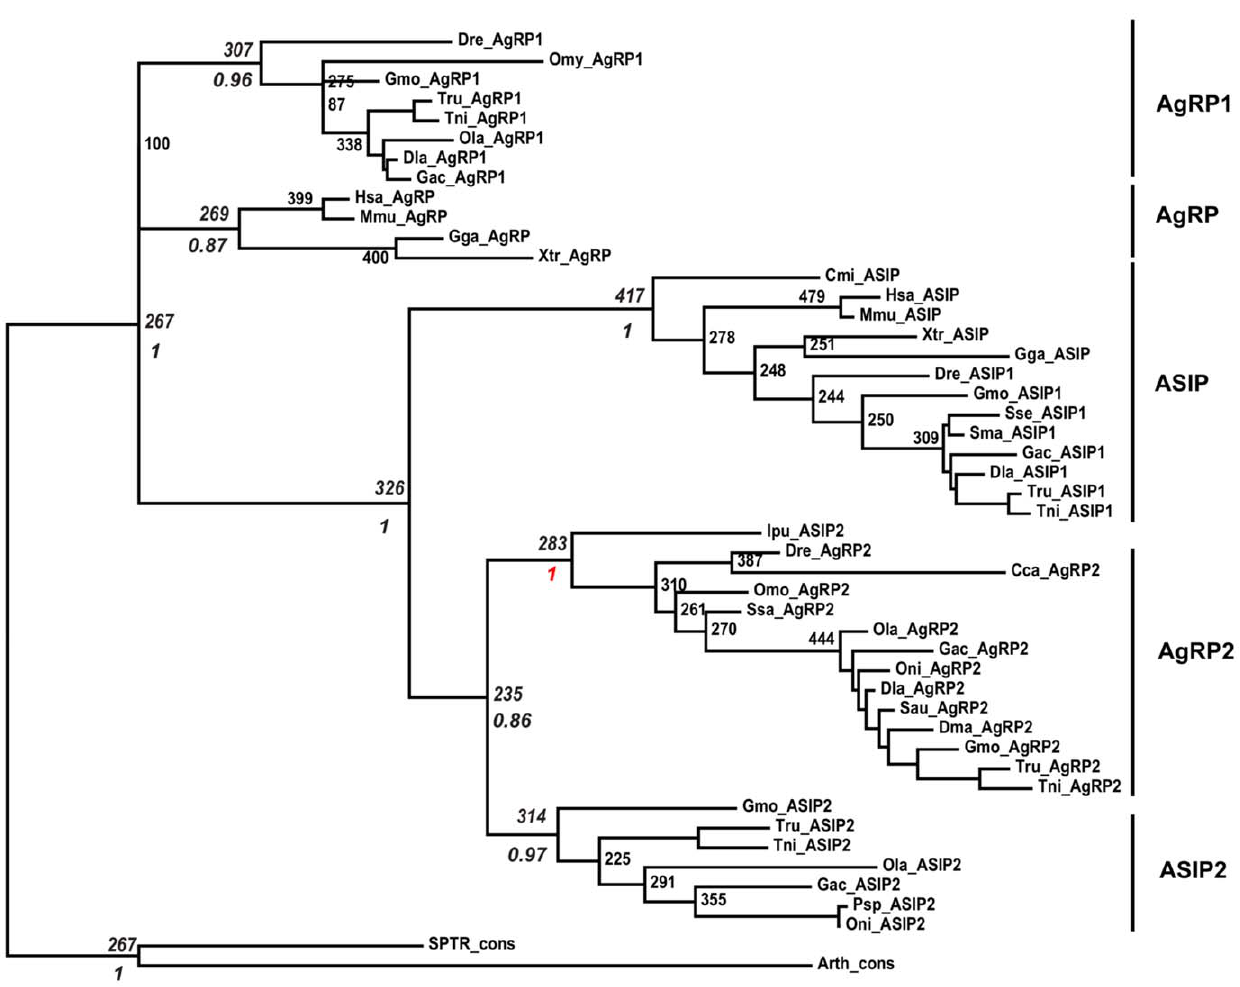
Figure 2. Phylogenetic analysis of Agouti-like sequences. The unrooted maximum likelihood phylogenetic tree of Agouti-like sequences. Robustness of the nodes is tested with the posterior probabilities based on MCMC analysis as implemented in the MrBayes program. Both bootstrap (out of 500 replicates) and the posterior probability support were given in italics for the significant nodes. The posterior probability (1) of the A2 node is highlighted in red color. The tree is rooted on the node that clustered the consensus sequences, which serves as out-group.The tree shows that A2 is likely to have branched from ASIP1 .